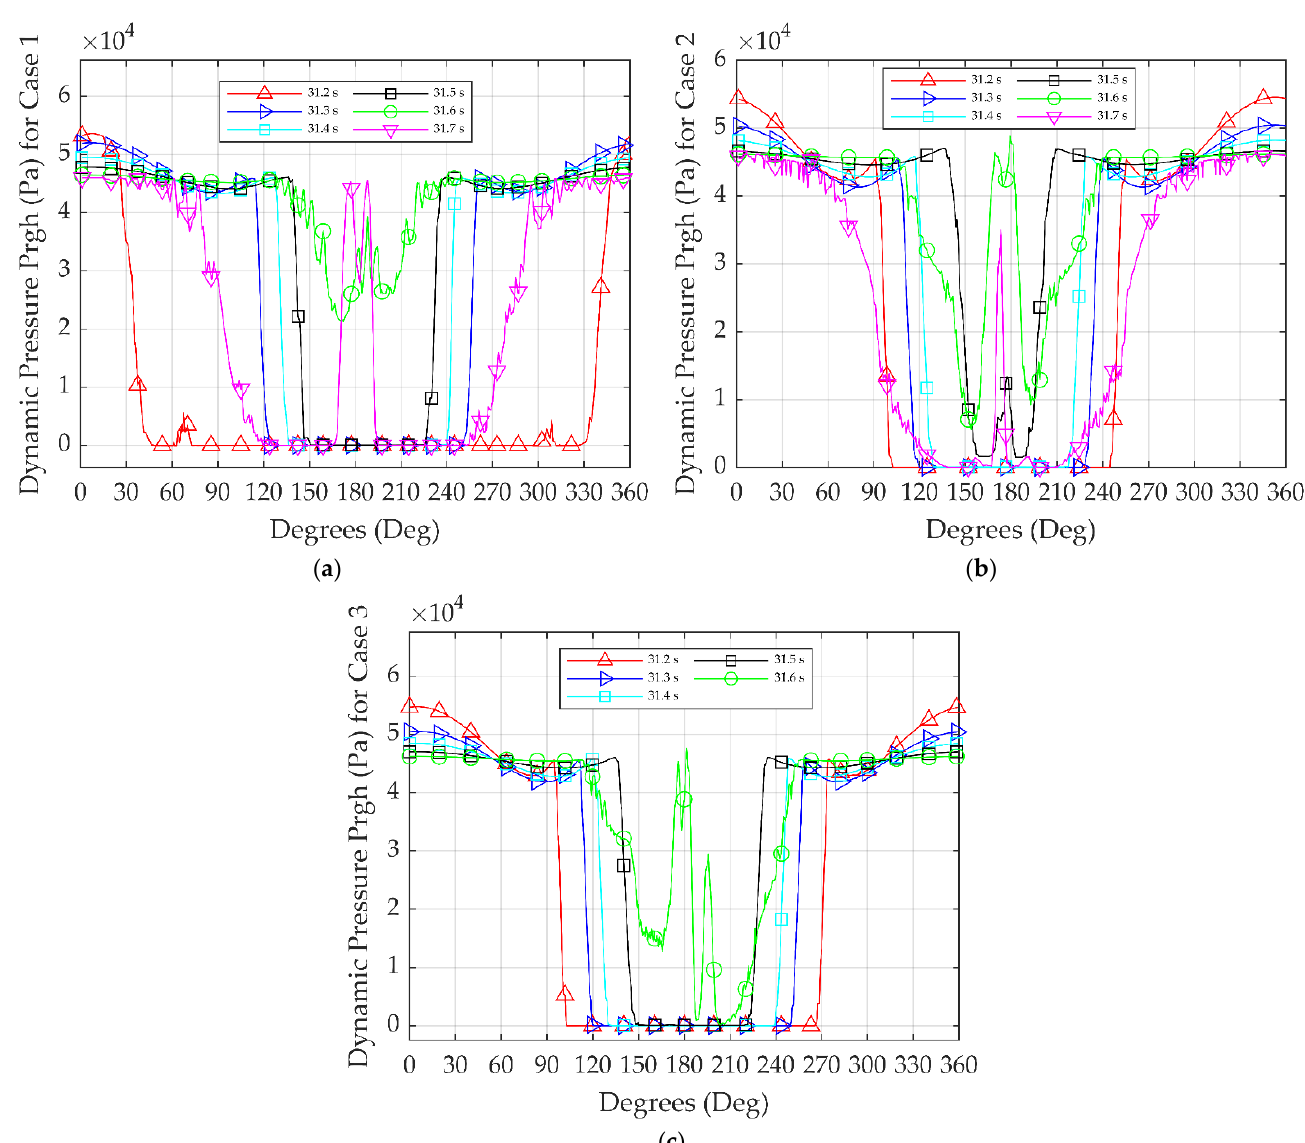
Figure 15. Pressure distribution around the substructure at different time steps for: ( a ) Case 1, ( b ) Case 2, and ( c ) Case 3.